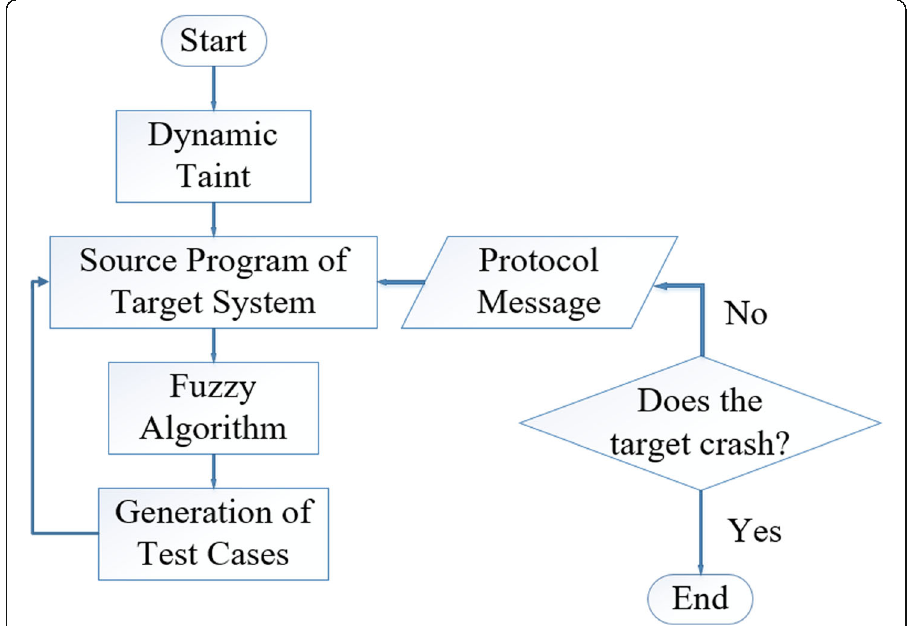
Fig. 4 Industrial Internet protocol fuzz test process based on dynamic